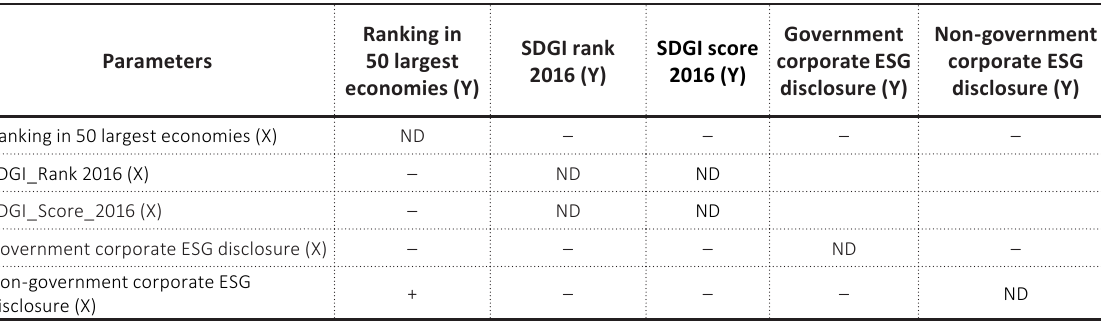
Table 4. Overview of the Granger causality test